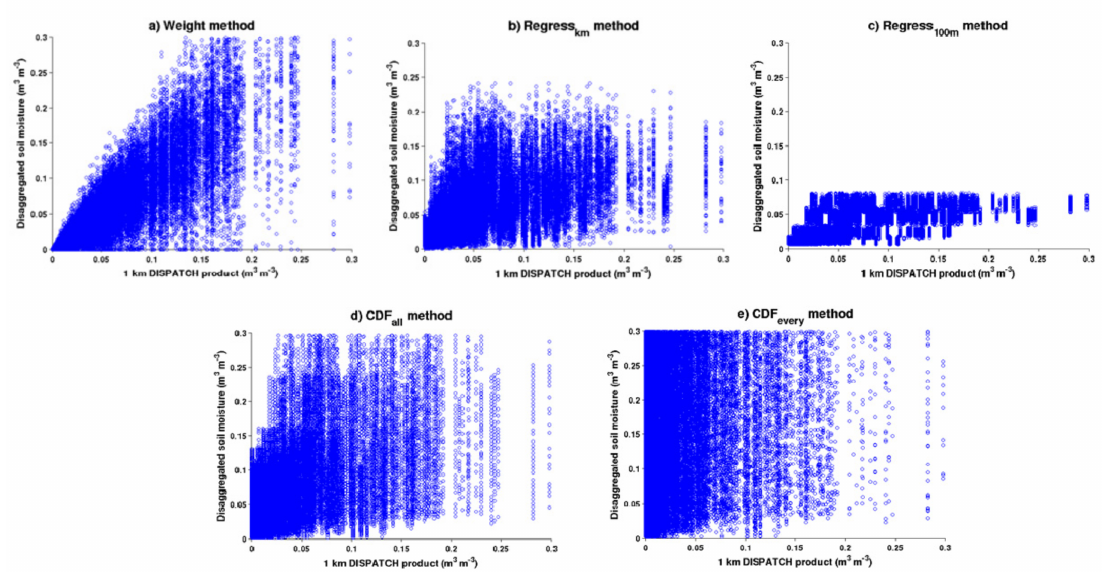
Figure 11. Scatter plots of disaggregated soil moisture (all pixels values of all disaggregated soil moisture maps after masking out values of vegetated areas) produced by: ( a ) weight; ( b ) regress km ; ( c ) regress 100 ; ( d ) CDF all ; and ( e ) CDF every methods against the corresponding 1 km DISPACTH